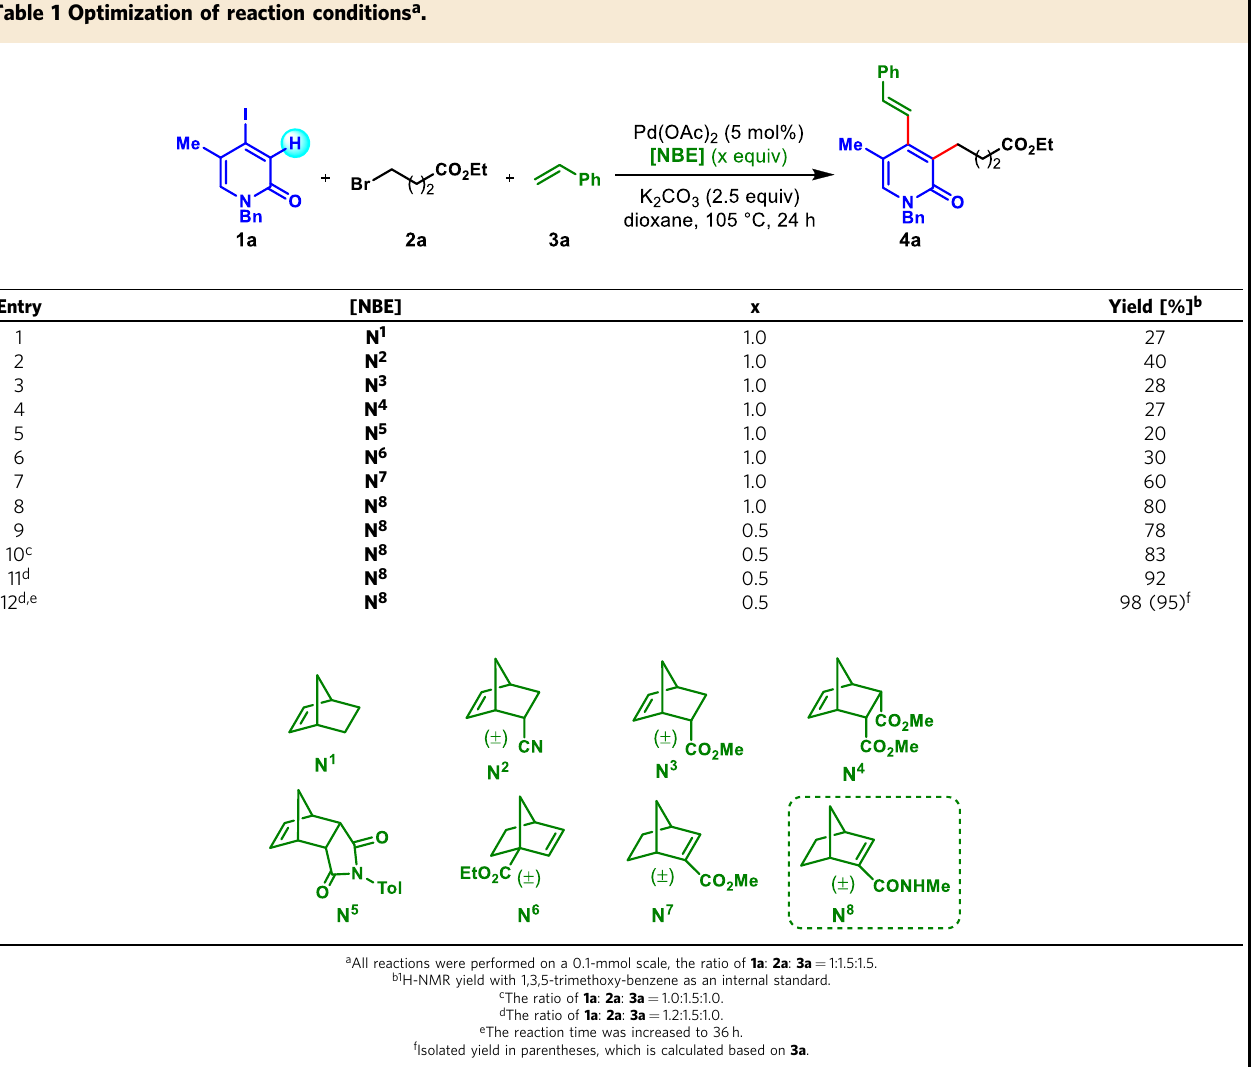
Table 1 Optimization of reaction conditions a